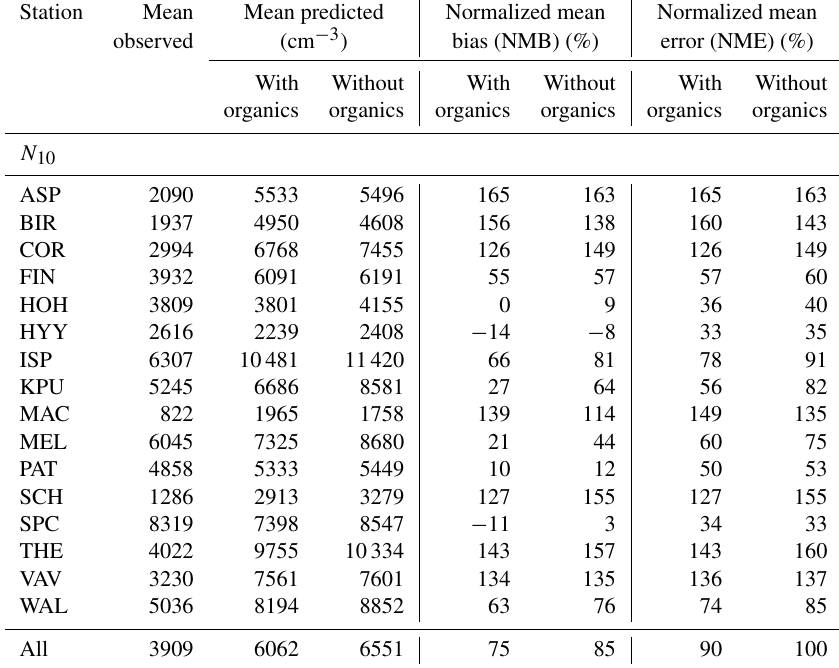
Table 1. Prediction skill metrics of PMCAMx-UF against daily ground measurements of particle number concentration with a diameter above 10nm from 16 stations during 5 June–8 July 2012. Station Mean Mean predicted Normalized mean Normalized mean observed With Without With Without With Without organics organics organics organics organics